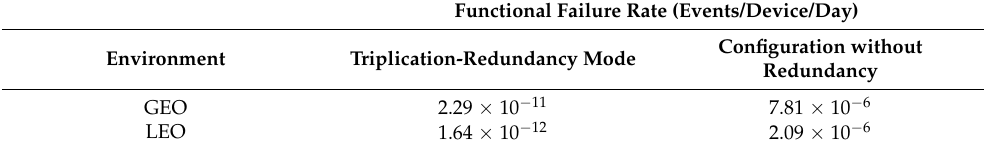
Table 7. Comparison of functional failure rates.